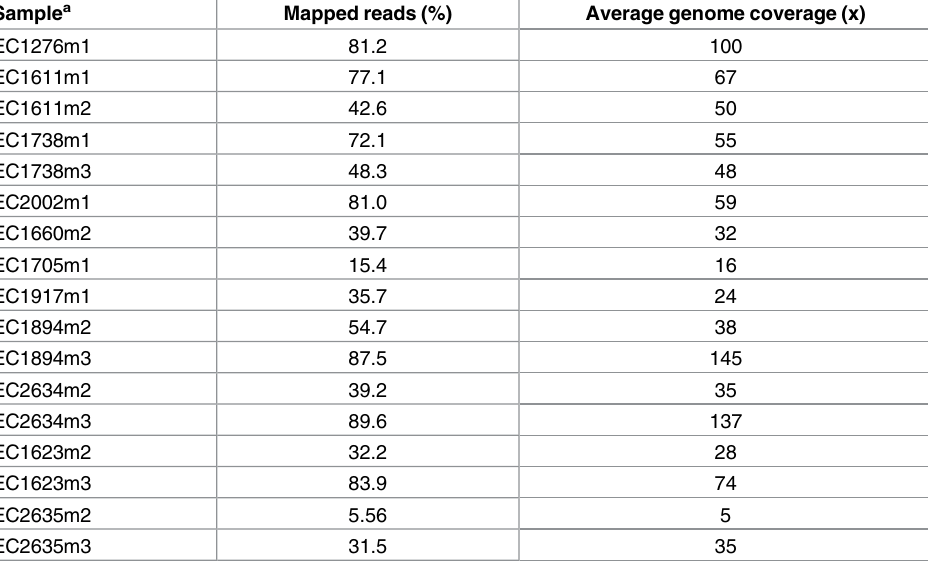
Table 3. Percent reads mapping to STEC genome and genome coverage. Sample a Mapped reads